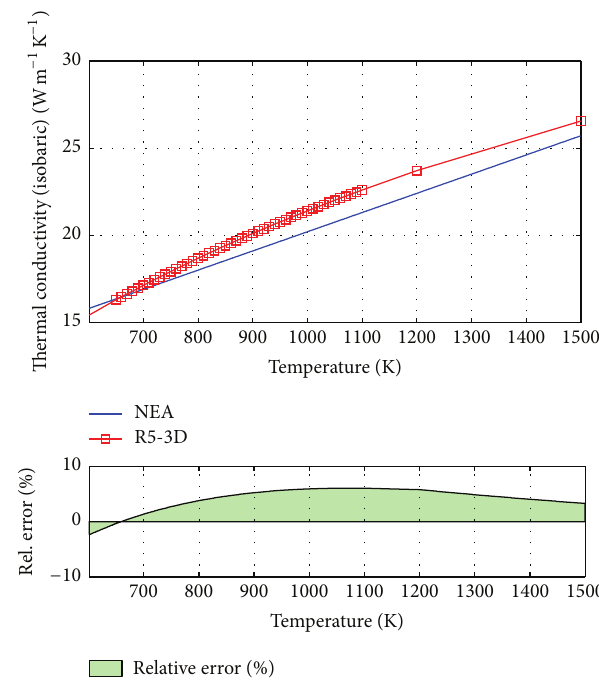
Figure11:Leadliquidthermalconductivity,originalR5-3D“tpf”file versus NEA